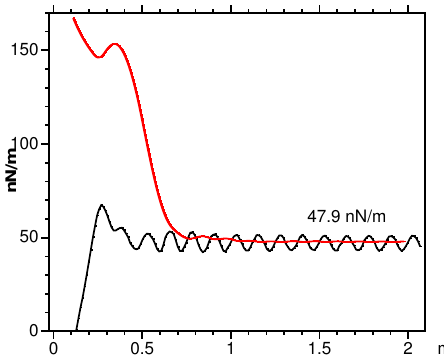
Figure 2. Time development of thrust in the Baseline, tether Coulomb force computation (black curve) and momentum-balance computation (red curve).